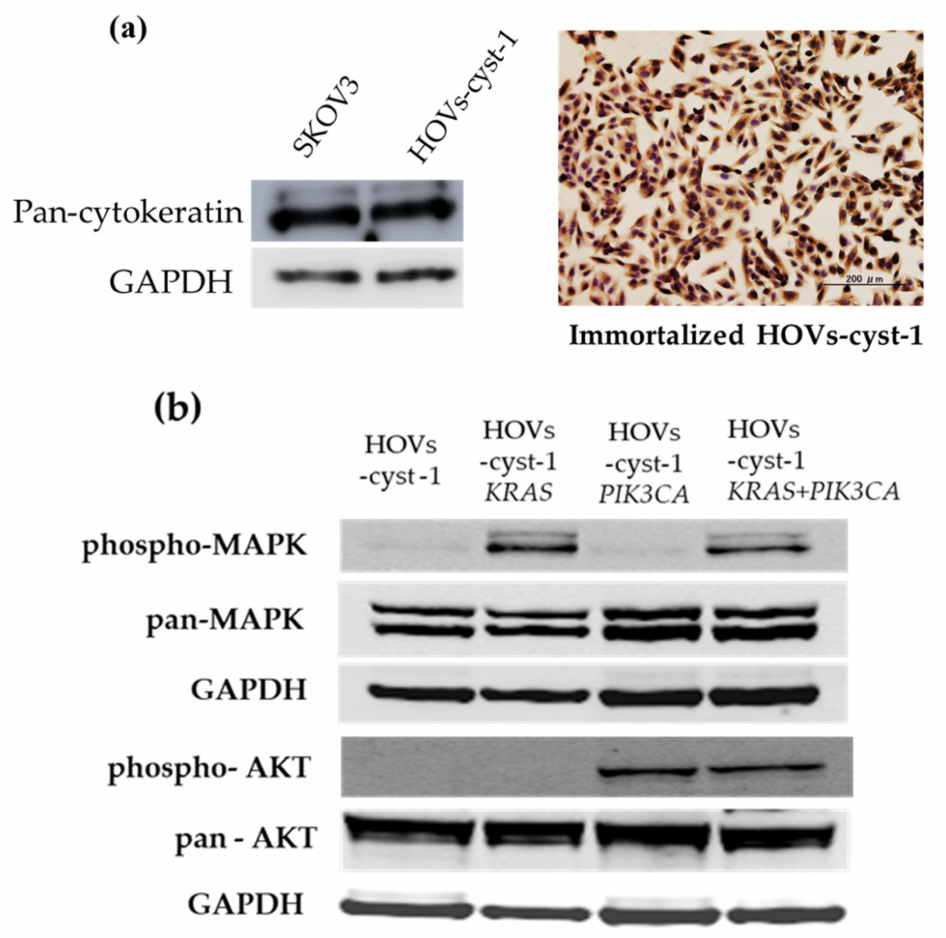
Figure 2. Characterization of HOVs-cyst-1 cells and oncogenes via western blot analysis and im- munohistochemistry. ( a ) Western blot analysis and immunohistochemistry of pan-cytokeratin in HOVs-cyst-1 cells. ( b ) Western blot analysis of phospho-MAPK, pan-MAPK, phospho-AKT, and pan-AKT expression in the series of HOVs-cyst-1 cells (original HOVs-cyst-1 cells, HOVs-cyst -1 KRAS cells, HOVs-cyst-1 PIK3CA cells, and HOVs-cyst-1 KRAS + PIK3CA cells). Uncropped Western Blots of pan-cytokeratin, phospho-MAPK, pan-MAPK, phospho-AKT, and pan-AKT expression can be found at Supplementary Figure